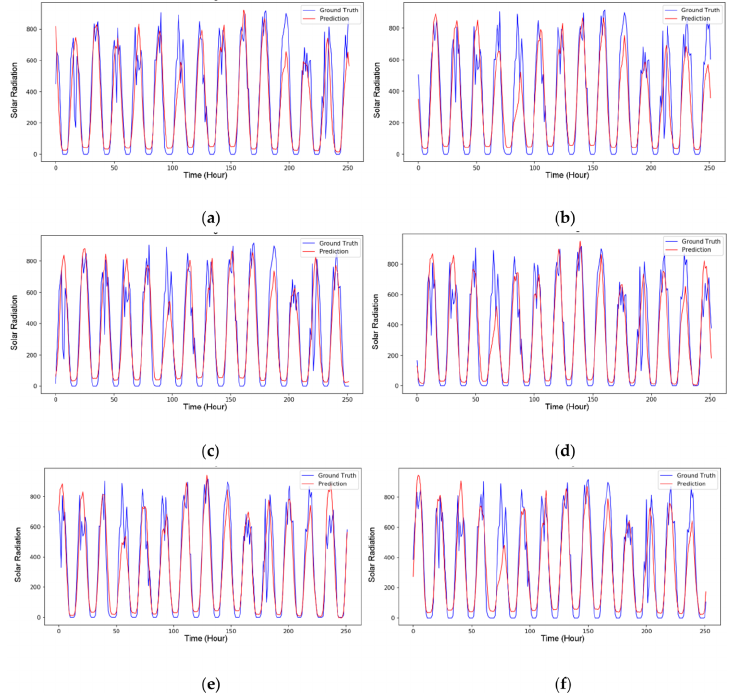
Figure 9. Forecasting results of support vector machine: ( a ) Partial results A; ( b ) Partial results B; ( c ) Partial results C; ( d ) Partial results D; ( e ) Partial results E; ( f ) Partial results